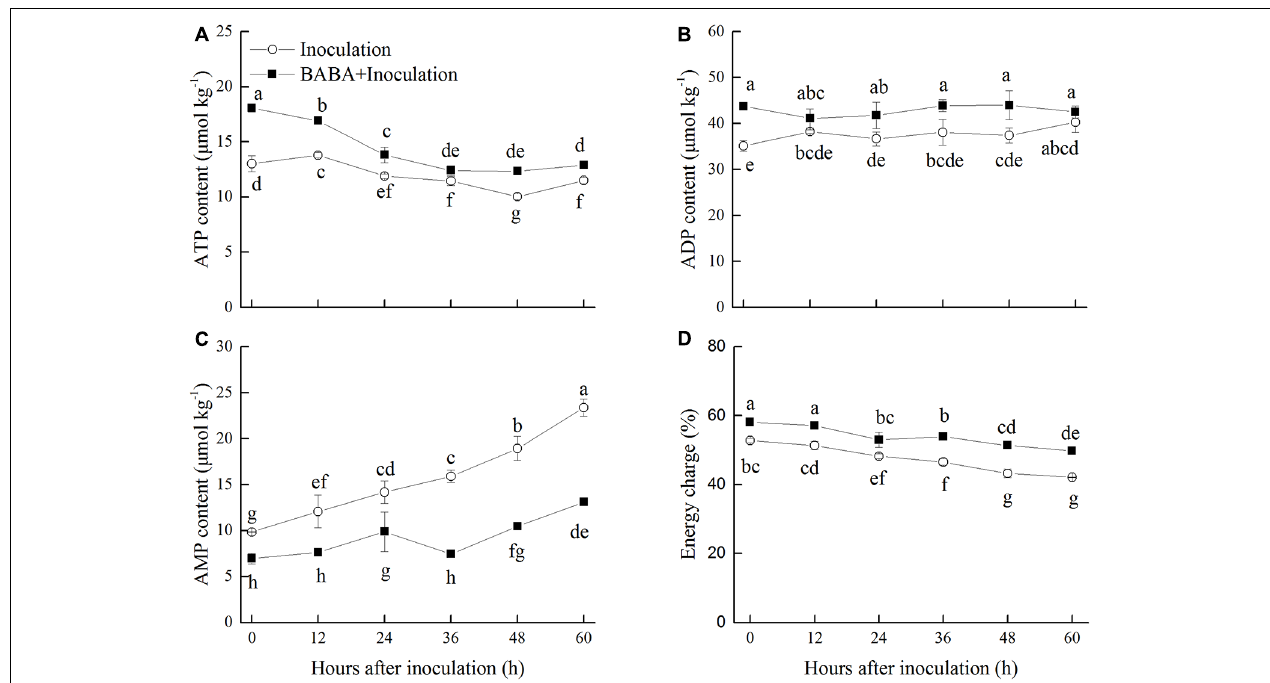
FIGURE 4 | Changes in contents of adenosine triphosphate (ATP, A ), adenosine diphosphate (ADP, B ), adenosine monophosphate (AMP, C ), and energy charge (D) in peach fruit inoculated with Rhizopus stolonifer (Inoculation) or pretreated with 50 mM BABA and then inoculated with R. stolonifer (BABA + Inoculation) during storage at 20 ◦ C. Data are expressed as the mean of triplicate samples. Vertical bars represent the standard errors of the means. Letters without the same letter above the bars indicate significant differences at P <